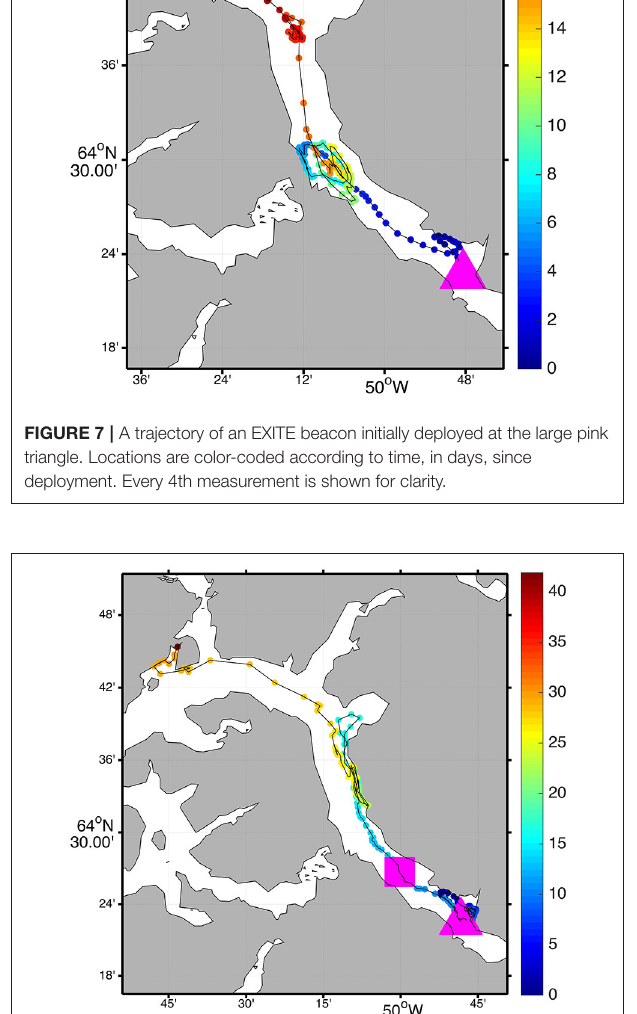
FIGURE 8 | A trajectory of an EXITE beacon initially deployed at the large pink triangle. Locations are color-coded according to time, in days, since deployment. Every 4th measurement is shown for clarity. The location where the critical acceleration was exceeded is indicated by the large pink